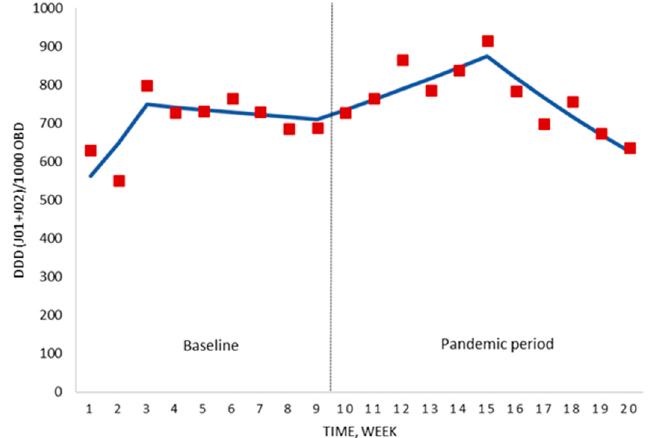
Figure 2. Segmented regression analysis of the hospital antimicrobial consumption for the period before the national lockdown (baseline) and the pandemic period. Red boxes represent the observed value for DDD/1000 OBD, and solid lines are the modelled regression trend segments characterised by the segmented joinpoint regression analysis. DDD, defined daily doses; ATC group J01 (antibacterials for systemic use) and J02 (antifungals); OBD, occupied bed days.